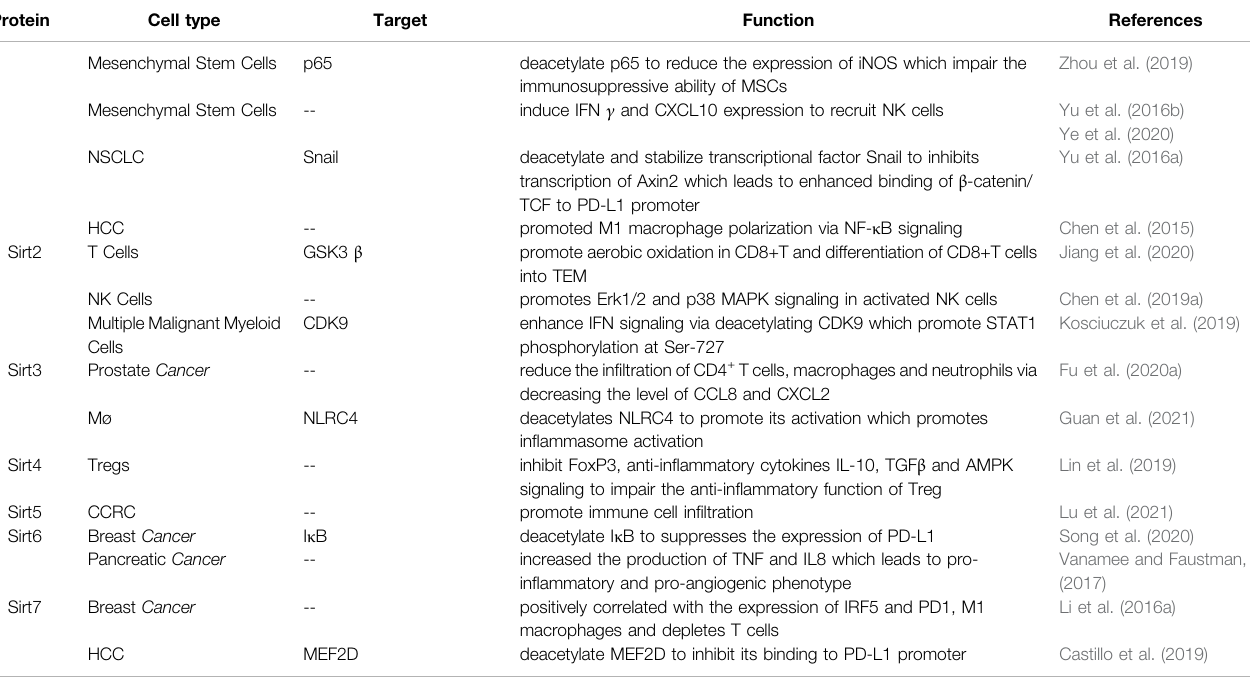
TABLE 2 | ( Continued ) Function of HADCs related to tumor immunity in different cell